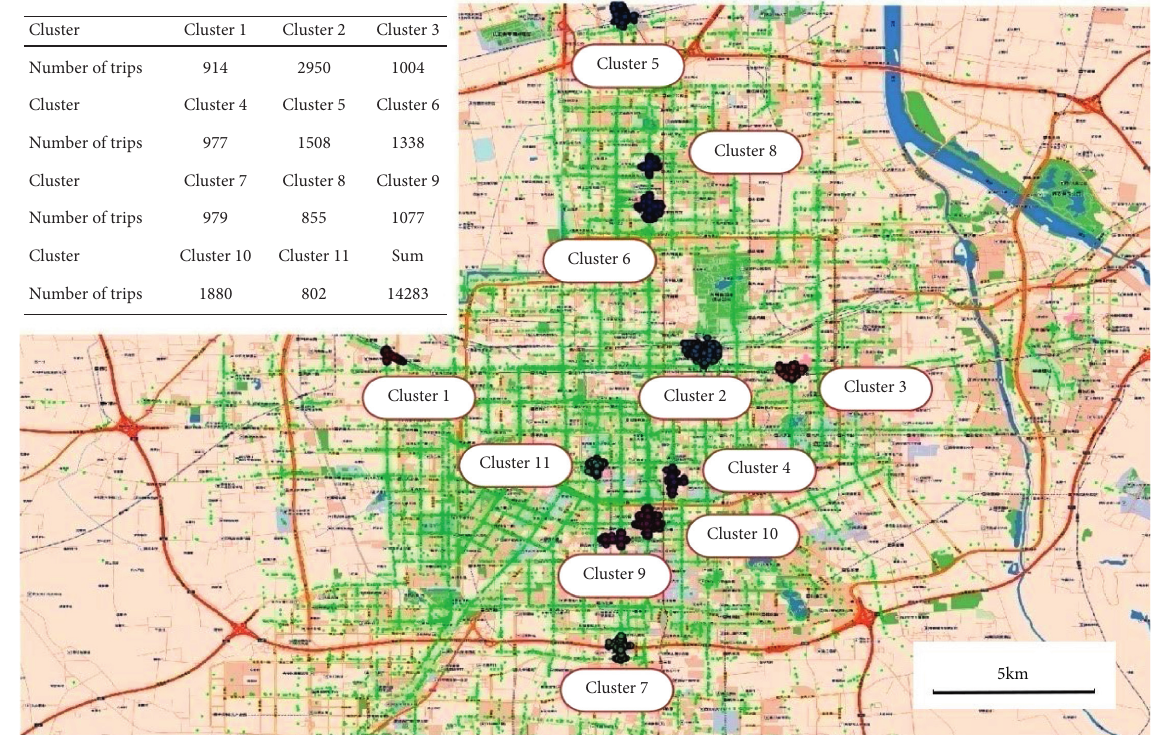
Figure 3: Spatial distribution of drop-off clusters. Table 2: Results of hotspot OD